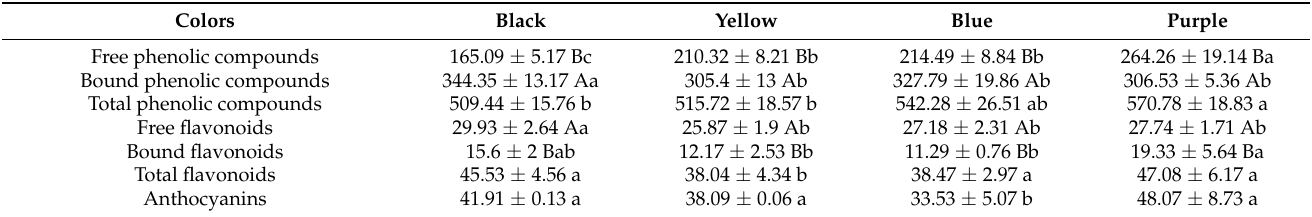
Table 1. Content of phenolic compounds in barley of different colors (mg/100 g). Colors Black